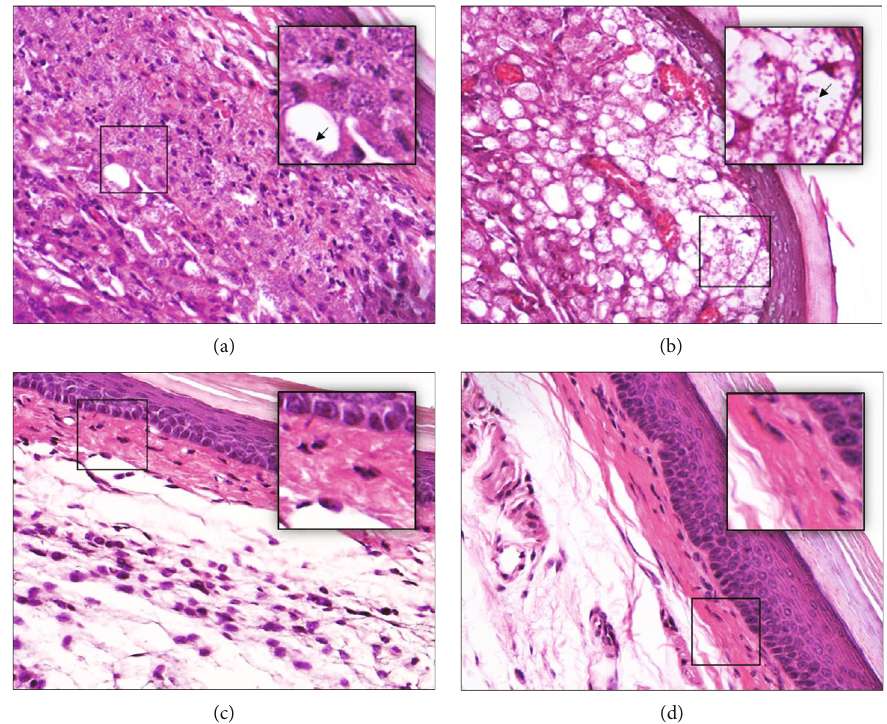
Figure 5: Histopathological analysis of the footpad of mice immunized with pVAX1::LmxMBA and challenged with promastigotes of L. mexicana . Tissues were collected 105 days after infection, and the sections were stained with hematoxylin and eosin. Vacuolated macrophages containing amastigotes were abundant in footpad lesions of mice immunized with PBS (b), as compared with mice immunized with the empty vector, pVAX1 (a); the dermis of control animals showed a massive in fi ltration with parasitized macrophages (arrows). In contrast, mice immunized with pVAX1::LmxMBA displayed more preserved skin with lymphocytes and macrophages containing few or no parasites (c). Microarchitecture of the dermis in mice immunized with pVAX1::LmxMBA was globally preserved in a similar manner to the healthy footpad (d).